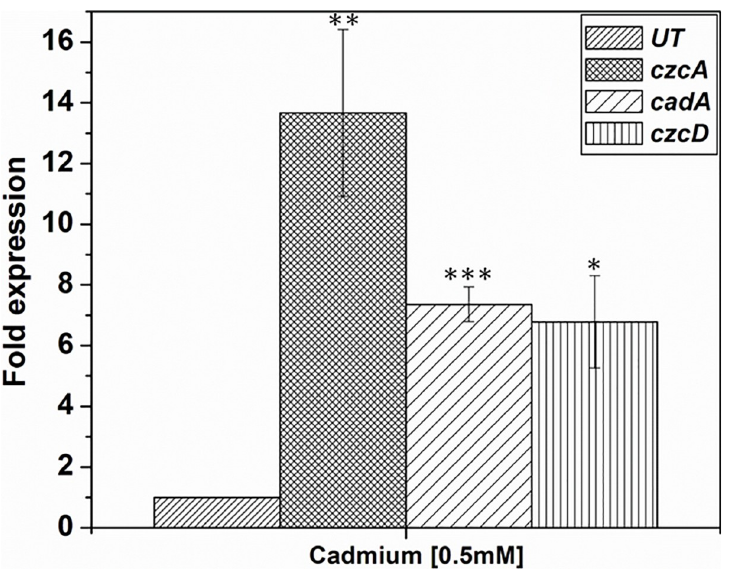
Fig 3. Expression of metal transporter genes in the presence of cadmium. Expression of czcA , czcD and cadA genes in response to treatment with 0.5mM Cd. Expression of these genes was normalized to the expression of the 16SrRNA gene. Statistical significance was performed using Student’s test (p � 0.05 � ; p � 0.01 � 0.001 �� ; p � 0.001 ��� .).